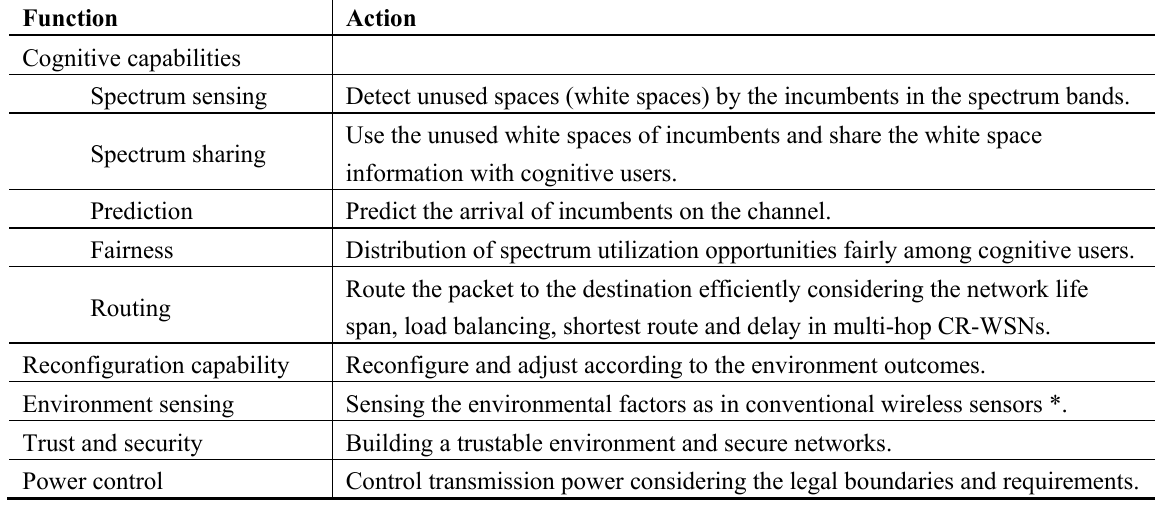
Table 1. Prospective capabilities of a wireless sensor with